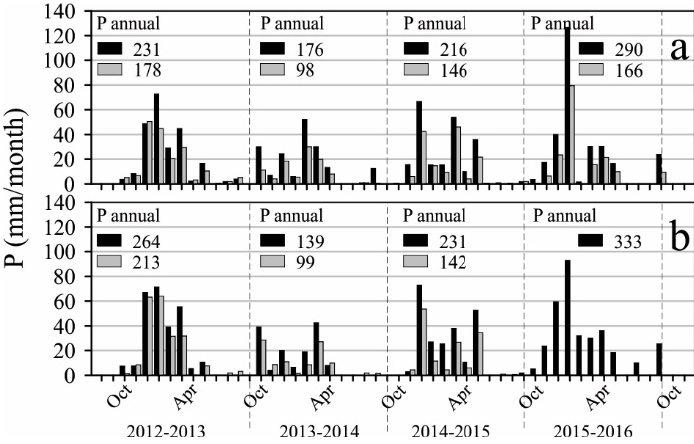
Figure 3. ( a ) Comparative analysis of monthly and annual precipitation patterns between CT (black bars), Guadalupe Valley (Vg; gray bars), ( b ) El Porvenir (Por; black bars) and Agua Caliente (Ac; gray bars) weather stations with information from 2012–2016.